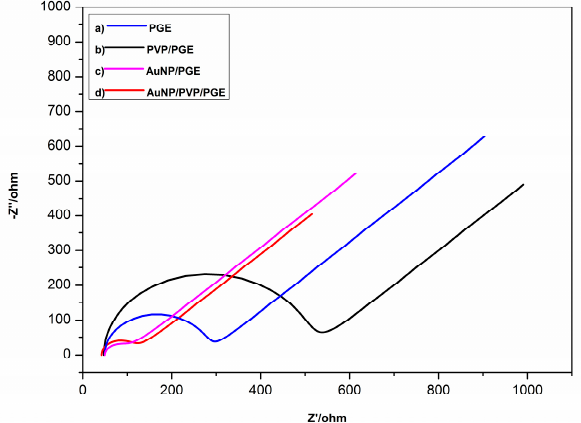
Figure 1. Nyquist diagrams of: ( a ) pencil graphite electrode (PGE); ( b ) polyvinylpyrrolidone (PVP)/PGE; ( c ) gold nanoparticle (AuNP)/PGE; ( d ) AuNP/PVP/PGE in 5 mM Fe(CN) 63 − /4 − 0.1 M KCl (E: 0.2 V; Frequency: 100,000–0.1 Hz).